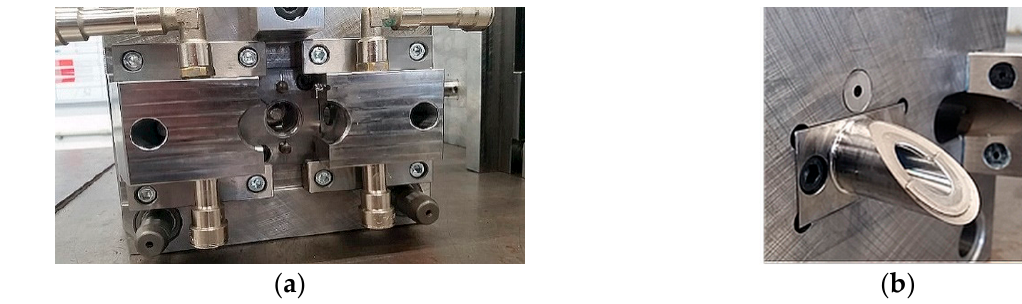
Figure 7. Injection molds for the ring of the inflow valve: ( a ) mold seat and ( b ) mold stamp.